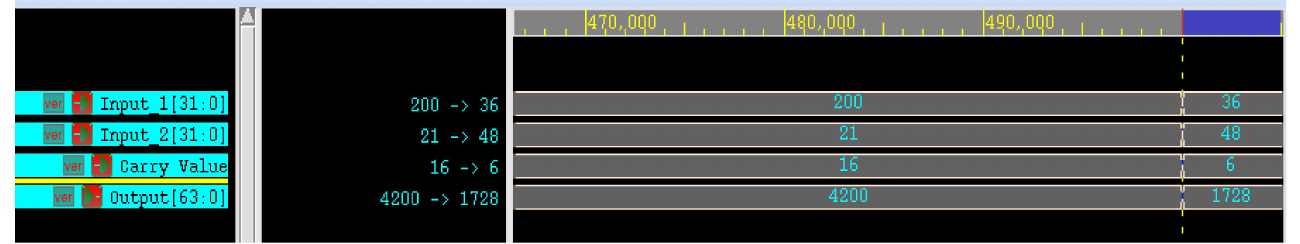
Figure 4. Simulation results of 32 × 32 Vedic multiplier. Table 1. Analysis report of conventional multiplier and proposed Vedic multiplier. Conventional Conventional Proposed Parameter Multiplier Vedic Multiplier Vedic Multiplier Power ( µ W) 26.351 27.235 23.33 Speed (ns) 6.213